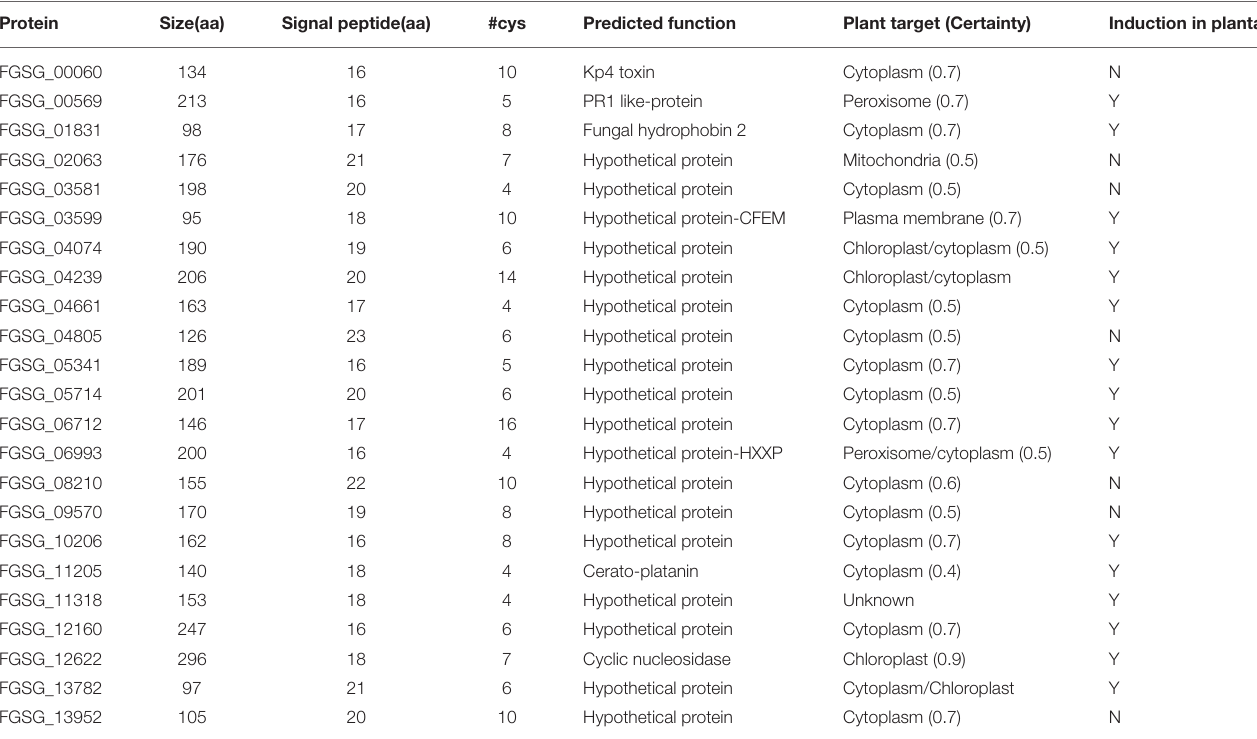
TABLE 1 | Characteristics of 23 F. graminearum effectors selected for gene expression study.